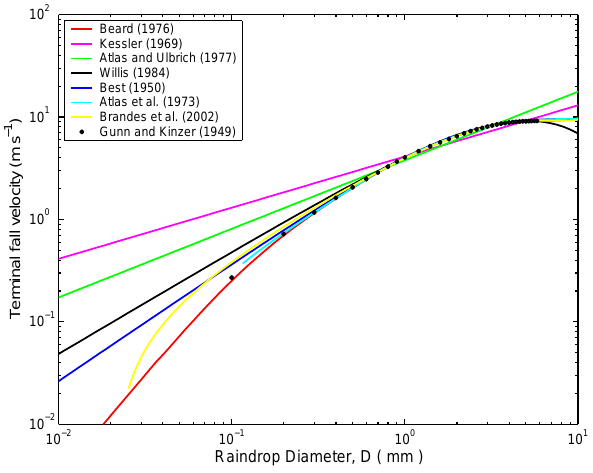
Fig. 6. Raindrop terminal velocity versus raindrop diameter for seven different parameterizations and measurements from Gunn and Kinzer (1949).